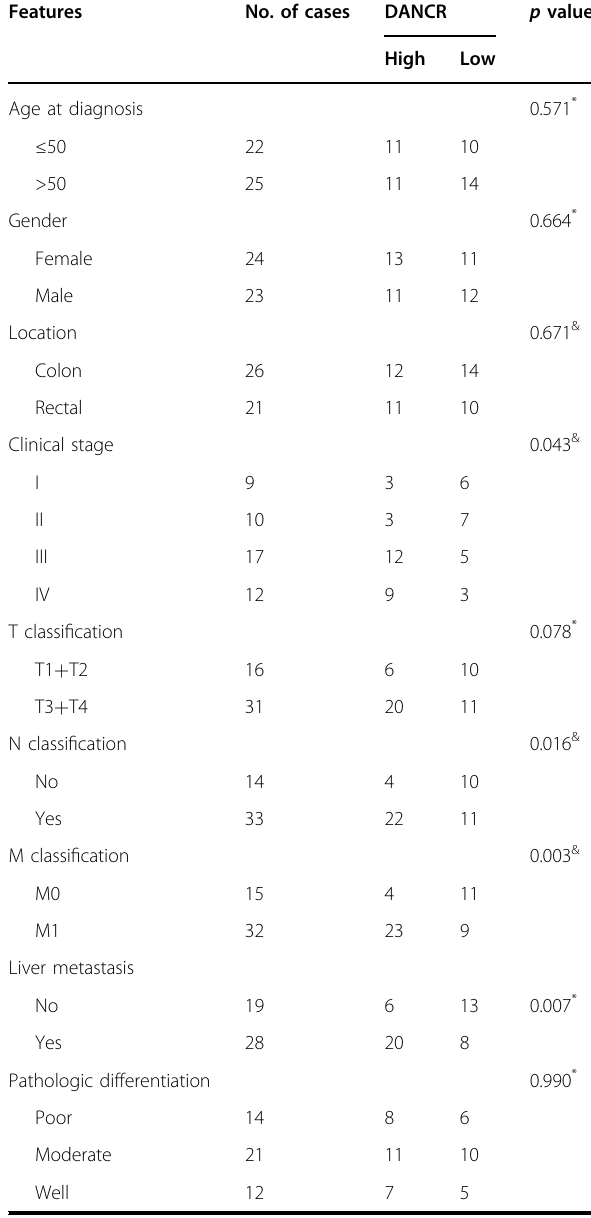
Table 1 Correlation of DANCR expression and clinicopathological features in CRC